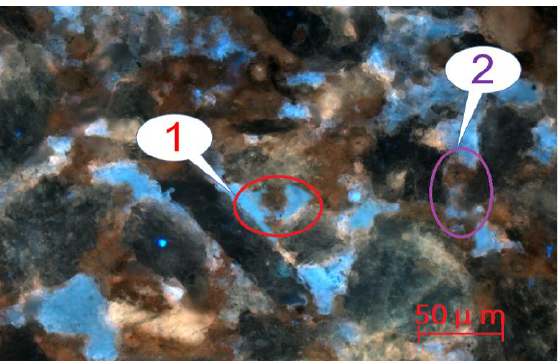
Figure 8. Schematic diagram of free-state remaining oil types.